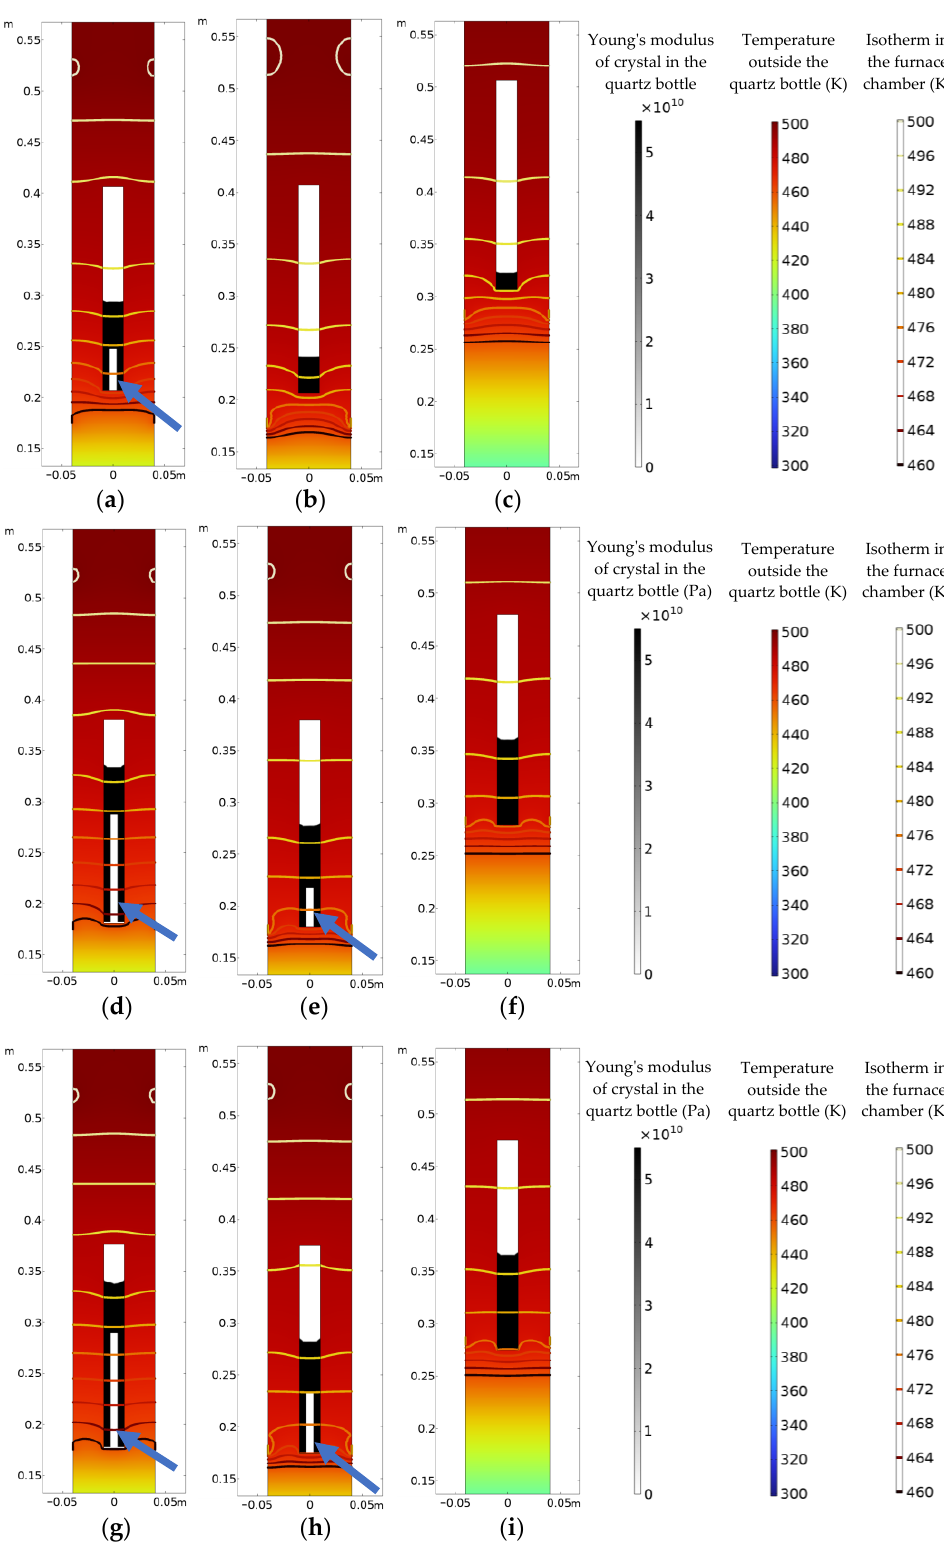
Figure 4. Crystal growth along the a -axis: ( a – c ) 160,000 s; ( d – f ) 260,000 s; ( g – i ) 275,000 s; ( a , d , g ) for process A; ( b , e , f ) for process B; ( c , f , i ) for process C.